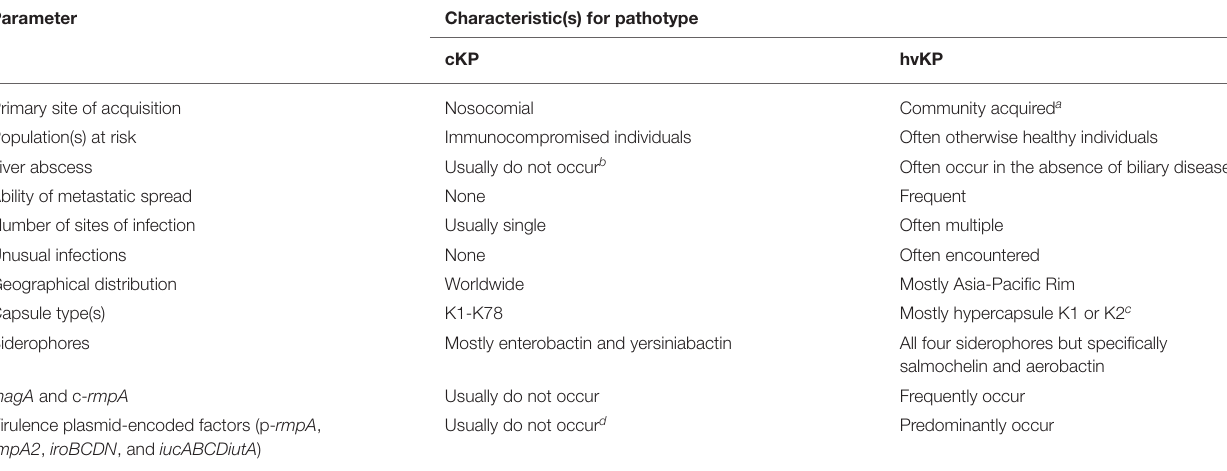
TABLE 2 | Characteristic features of classical K. pneumoniae (cKP) and hypervirulent K. pneumoniae (hvKP)